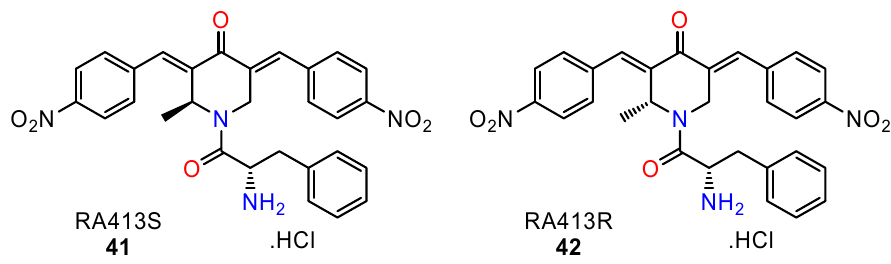
Figure 19. The structure of chiral proteasome inhibitors ( 41 – 42